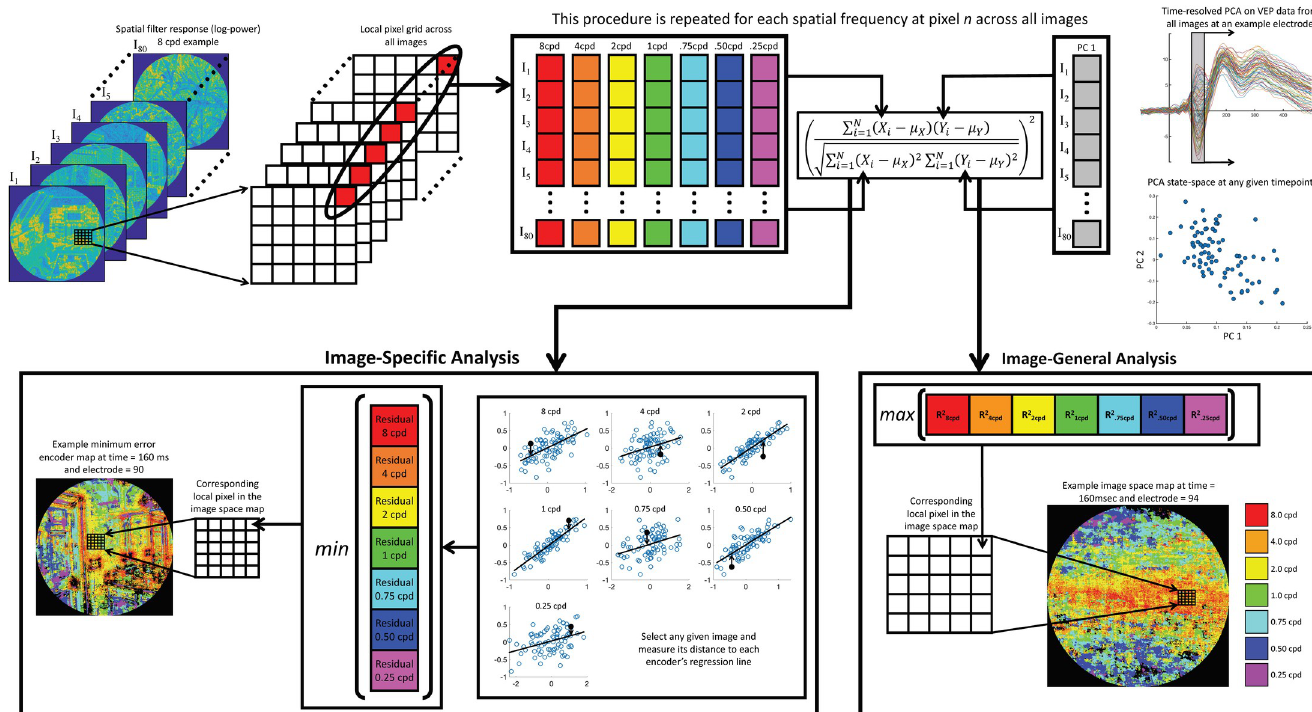
Fig 3. Schematic illustration of the DETI mapping procedure. All stimuli were represented in a log-Gabor filter power response space defined by seven peak SFs at each pixel coordinate across all stimuli (8 cpd encoder response examples in the upper left). For any given time point and electrode, and at any given pixel coordinate, we sampled the filter responses across all images for a given encoder and assembled them into an 80 x 1 array (this was repeated for each encoder). Then, for any given time point and electrode, each encoder’s 80 x 1 filter response array was regressed against the first PC taken from VEP data evoked by all images at the corresponding time point. Two types of maps were then produced: image-general maps (bottom right) and image-specific maps (bottom left). The image-general tagged each pixel coordinate with the SF of the encoder that had the highest R 2 . Similarly, the image-specific analysis was designed to find the encoder that could best predict the VEP variability across all images captured by the first PC for any given stimulus. However, instead of using the best fit across all images, this analysis finds the encoder regression fit that had the shortest distance (i.e., smallest residual) to a given image and tagged the corresponding pixel location with that encoder’s SF.